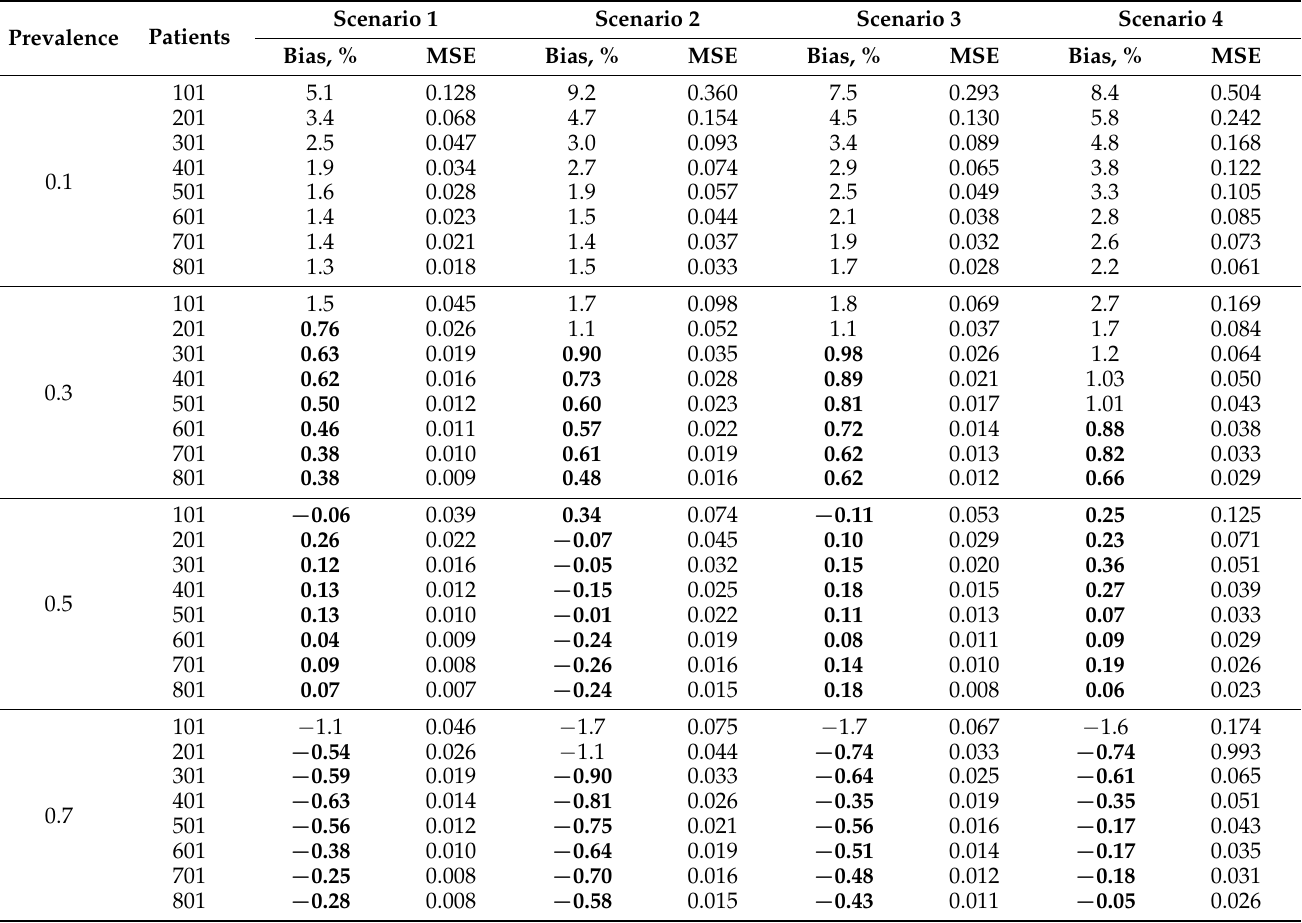
Table 2. Bias and mean squared error (MSE) of cut-off points in fixed sample designs.